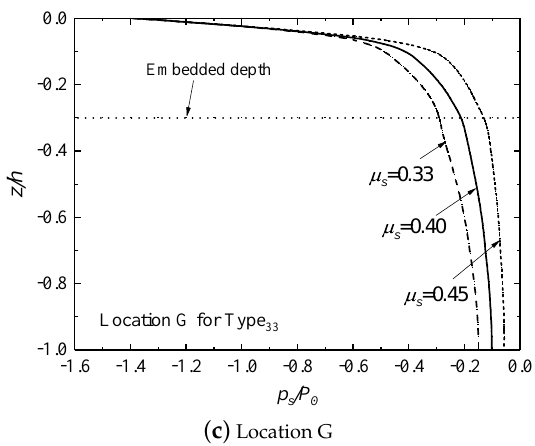
Figure 22. Vertical distributions of pore pressure with various Poisson’s ratio for Type 33 at t = 83.5